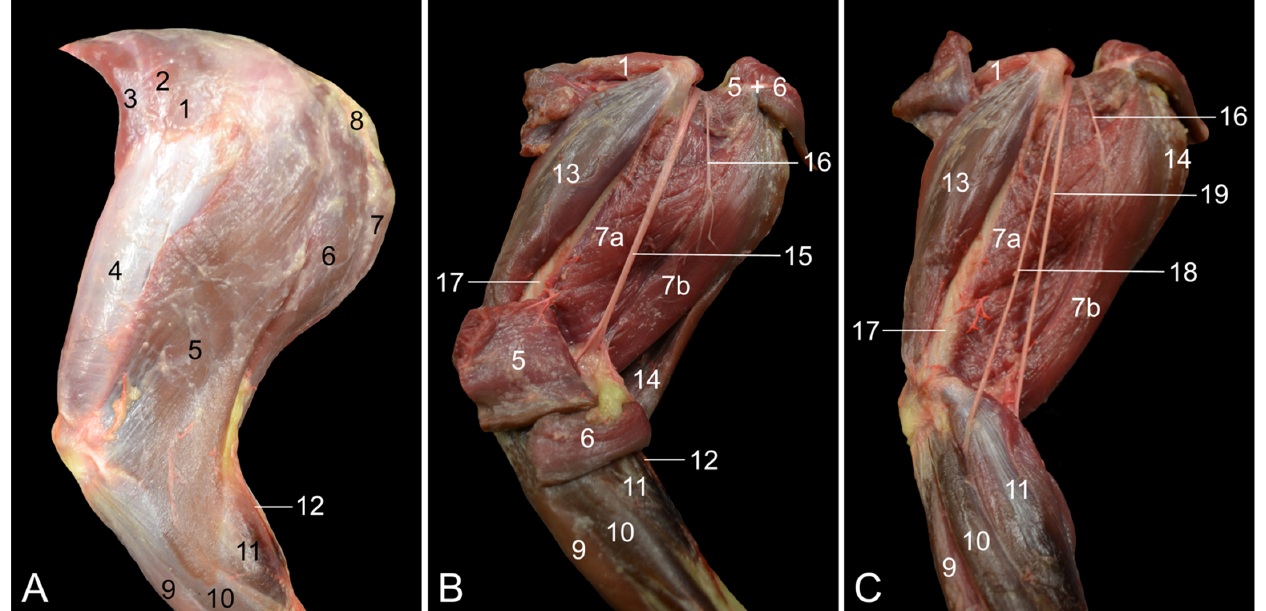
Figure 4. Caudolateral views of the left upper hindlimb. ( A ) Superficial layer; ( B ) second layer after the m. biceps femoris and the m. semitendinosus were transected and their stumps were retracted; ( C ) deepest layer after the stumps of the m. biceps femoris and m. semitendinosus were